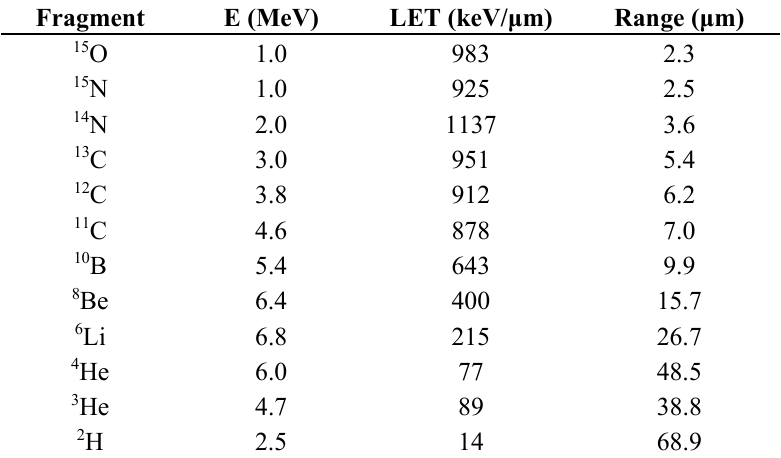
Figure 4. Fraction of primary protons undergoing inelastic nuclear reactions along the Bragg peak in a water target for 250 MeV initial beam energy (black symbols). The corresponding total reaction cross section values at the given positions were calculated according to the database currently adopted in the treatment planning system TRiP98 [115,116] (red symbols). The inset shows a zoom in the last 4 cm of range. Table 1. Expected average physical parameters for target fragments produced in water by a 180 MeV proton beam. The initial average energies of secondary fragments are calculated according to the Goldhaber formula (Equation (5)), considering the dependence of p F on the fragment mass (Equation